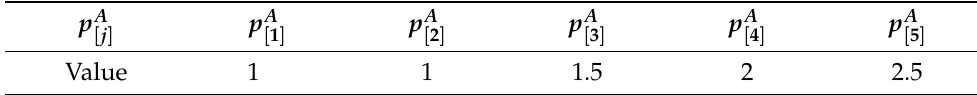
Table 3. Actual processing time.